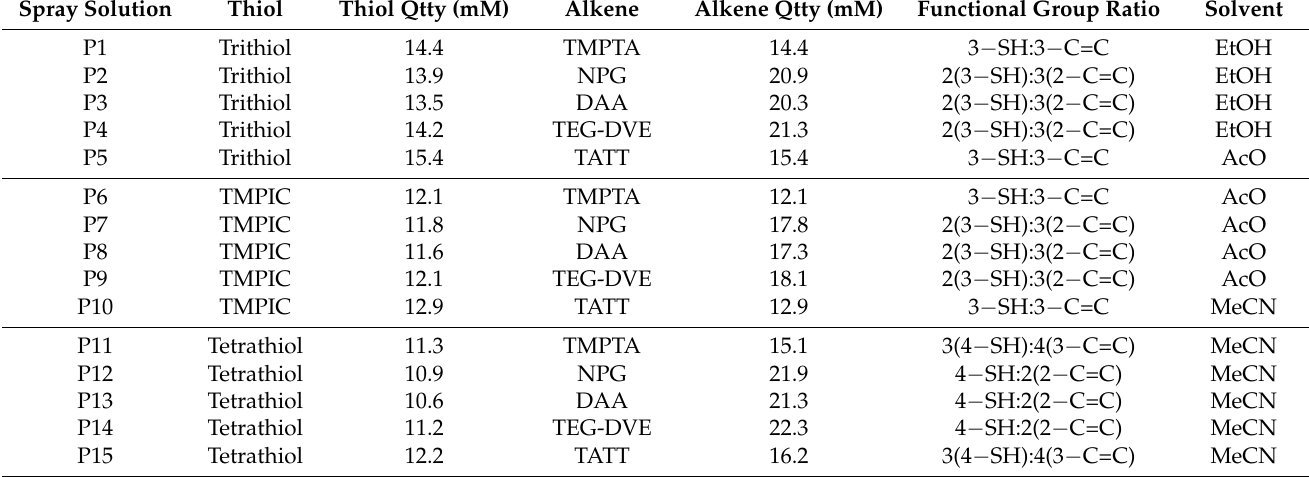
Table 1. Formulations of spray solutions with monomers and their quantities and the chosen solvent. The amount of the solvent is the same (10 g) in all samples, the amount of photoinitiator in all spray solutions is 1 wt% ratio to combined monomers. Equal stoichiometry (1:1 ratio) of functional groups ( − SH for thiol and − C=C for double bonds) was considered in each spray solution.